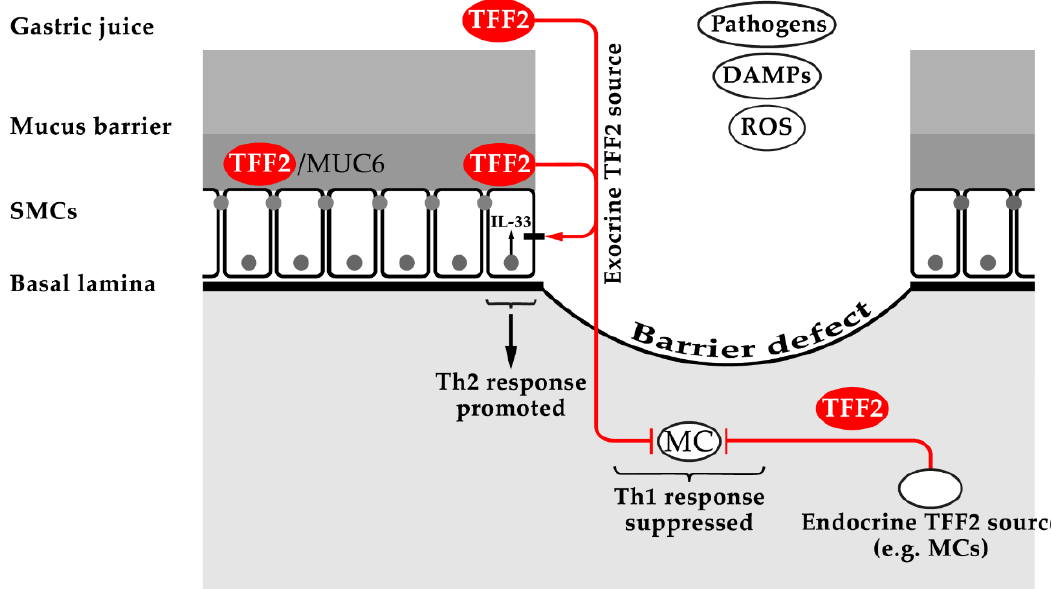
Figure 3. Schematic representation of the putative functions of TFF2 in the normal gastric mucosa as well as after injury/infection. The TFF2/MUC6 complex probably stabilizes the inner gastric mucus barrier layer at the apical side of surface mucous cells (SMCs); the mucus as well as the luminal content of the stomach are separated by tight junctions from the basolateral side of SMCs. After a barrier defect, exocrine TFF2 might stimulate a putative TFF2 receptor (such as CXCR4) at the basolateral surface, leading to an increased synthesis of the nuclear alarmin IL-33 and promotion of a Th2 response (after IL-33 release probably by a non-classical secretory mechanism via exosomes [161]). Furthermore, exocrine TFF2 as well as TFF2 from endocrine sources probably have an inhibitory effect on myeloid cells (MC; see also Section 4.1), repressing a Th1